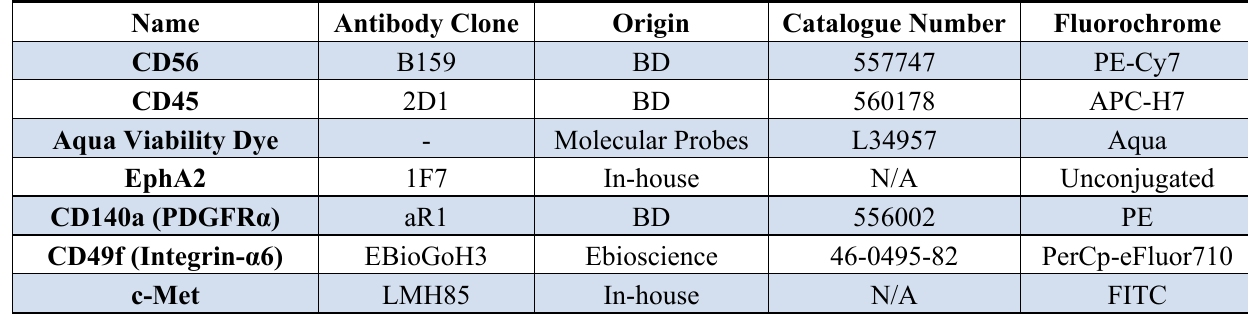
Table A2. List of antibodies used in multiplex color